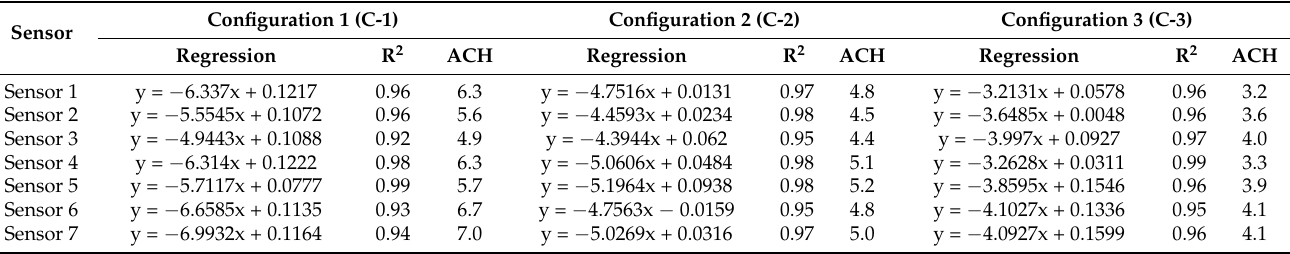
Table A2. Decay curves in Classroom B1-A2.